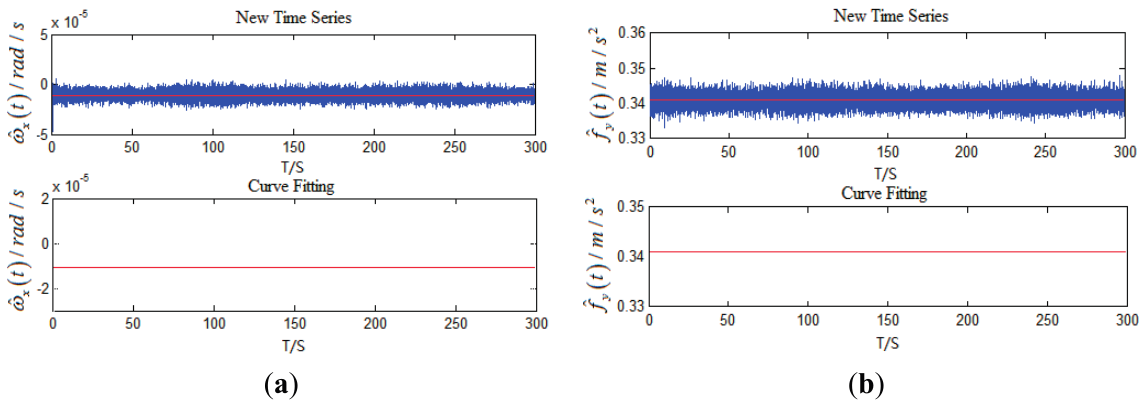
Figure 6. ( a ) The new time series and curve fitting of gyro; ( b ) The new time series and curve fitting of